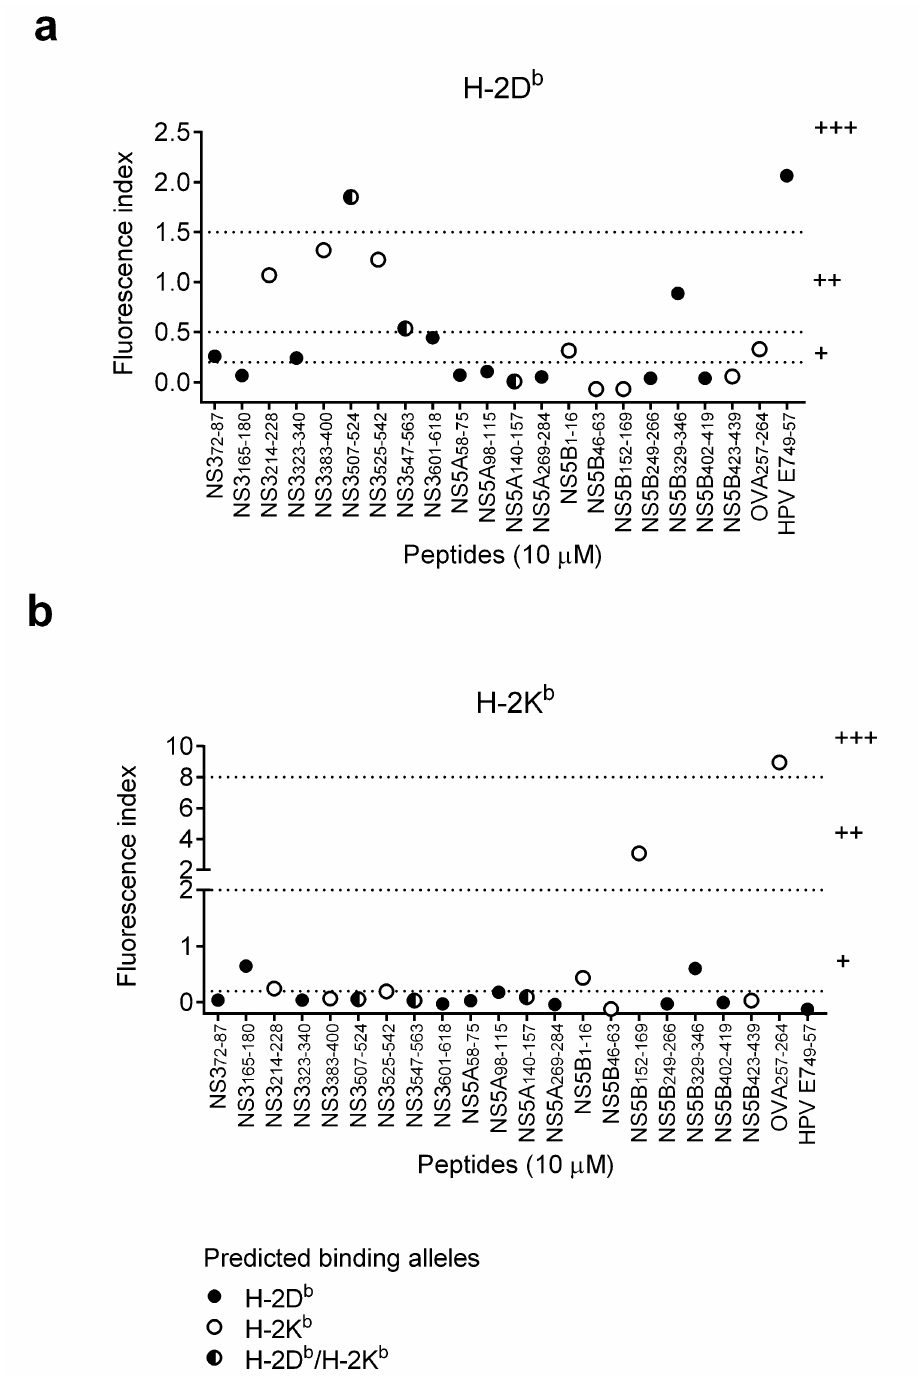
Figure 1. Stabilization of MHC class I molecules with binding of HCV SLPs. To induce MHC class I expression on cell surface, RMA-S cells were cultured at 26 °C for 48 h prior to the incubation with SLPs. Cells were then incubated with 10 μM of SLPs at 26 °C for 4 h, followed by a 1-h cultured at 37 °C. The expression levels of surface MHC class I molecules, ( a ) H-2D b and ( b ) H-2K b , were analyzed using flow cytometry. HPV E7 49–57 and OVA 257–264 short peptides were positive controls for binding to H-2D b and H-2K b molecules, respectively. Dash lines indicate the cutoff values for H-2D b (0.2–0.5: weak binders (+); 0.5–1.5: intermediate binders (++); >1.5: strong binders (+++)) and H-2K b (0.2–2: weak binders (+); 2–8: intermediate binders (++); >8: strong binders